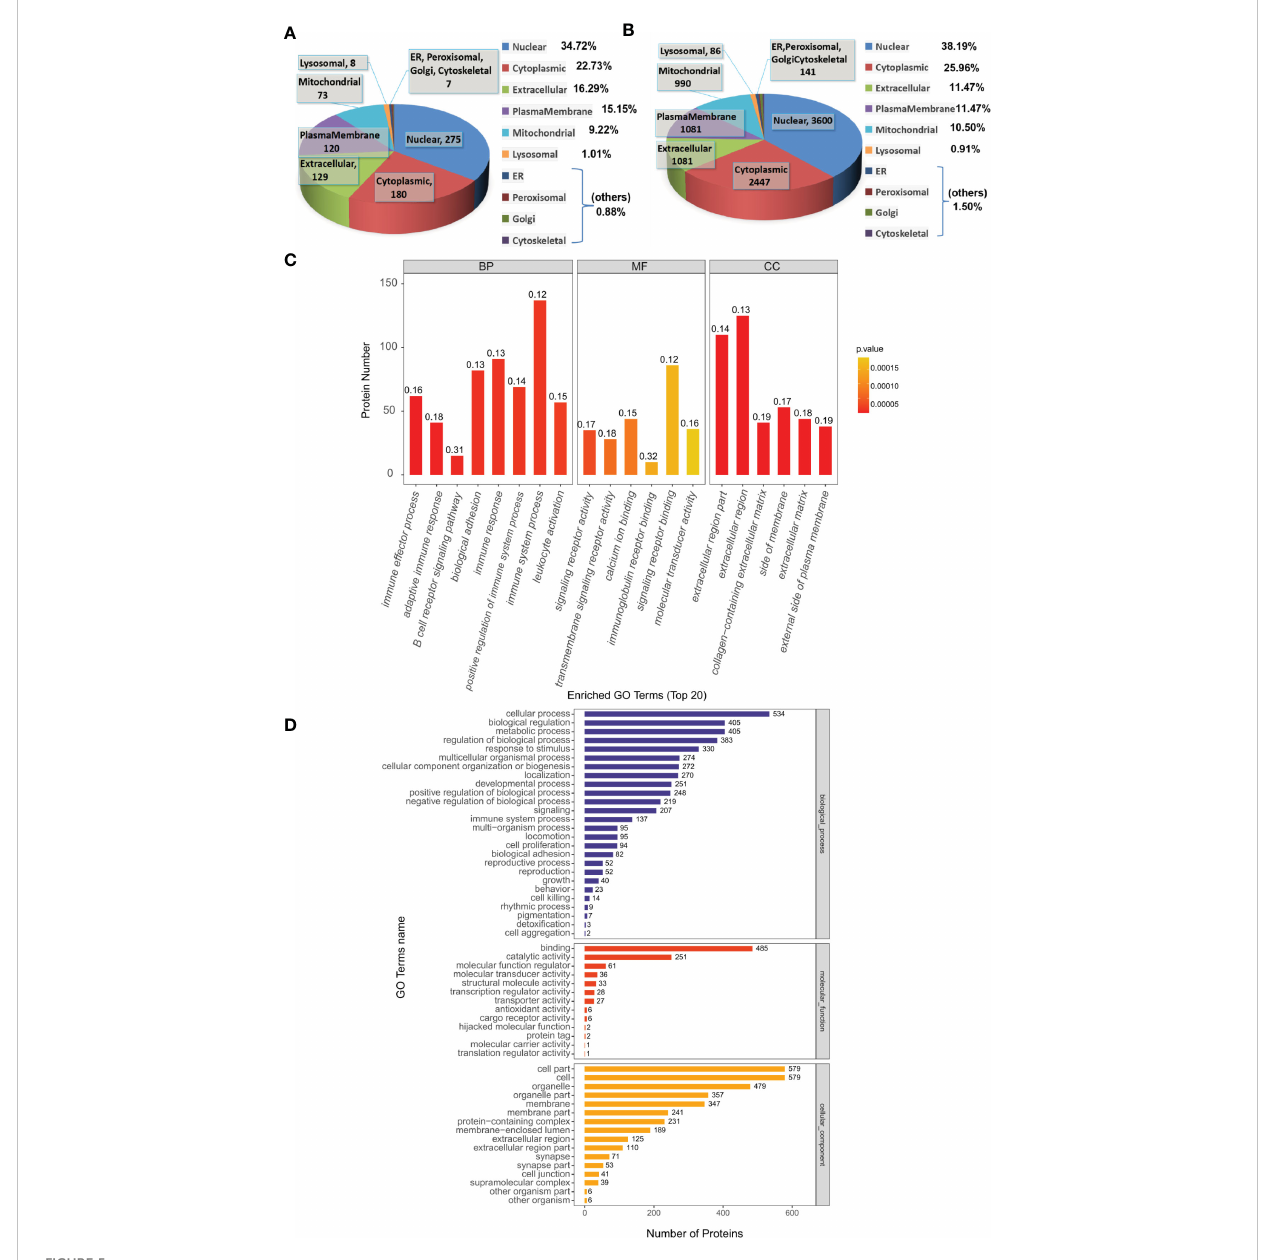
FIGURE 5 Functional analysis of DEPs. (A, B) Subcellular localization analysis of DEPs in Sema/HFD group and total proteome. The numbers show the proteins located in different subcellular components. (C) Overall enriched GO terms of DEPs between the Sema and HFD groups. BP: biological